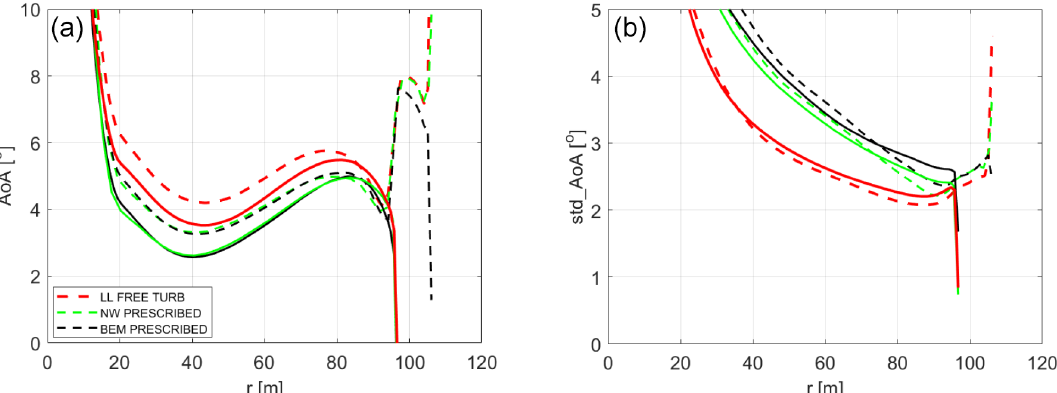
Figure 18. Angle of attack (a) mean distribution and (b) standard deviation. Solid lines represent the baseline blade, while dashed lines represent the optimized tip